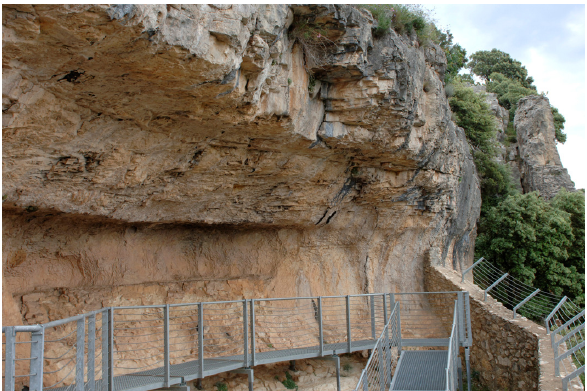
Figure 1. Partial view of Remigia Cave targeting Shelters IV-VI